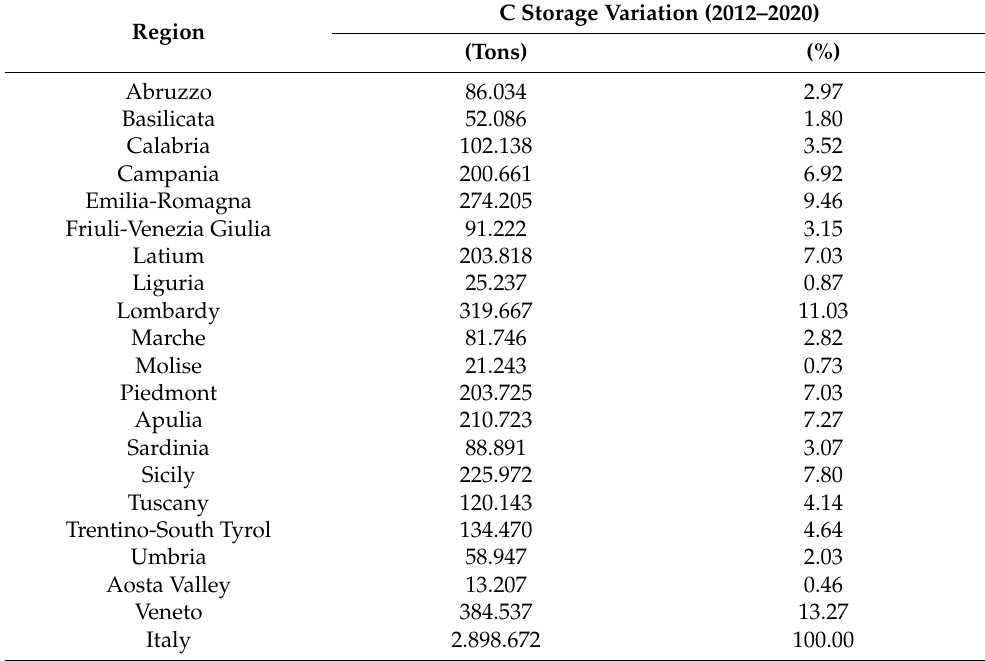
Table 13. Variation in carbon storage capacity (2012–2020).